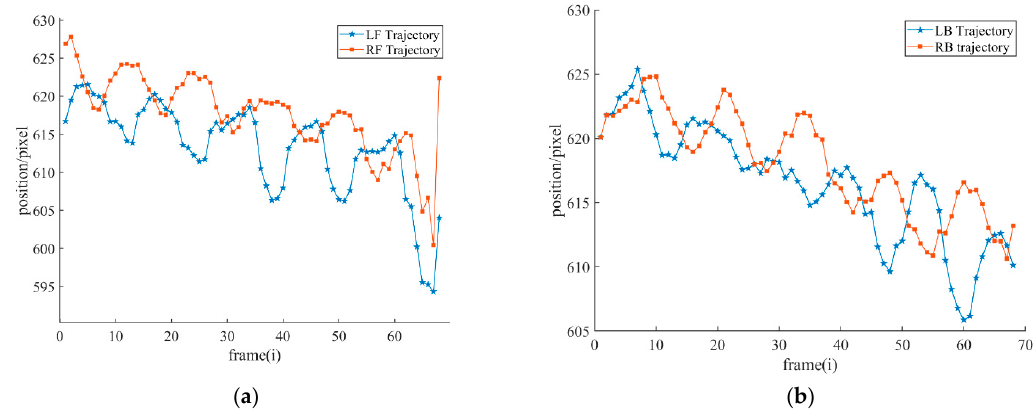
Figure 23. ( a ) Foot trajectory of dog’s forelimbs; ( b ) foot trajectory of dog’s hindlimbs.